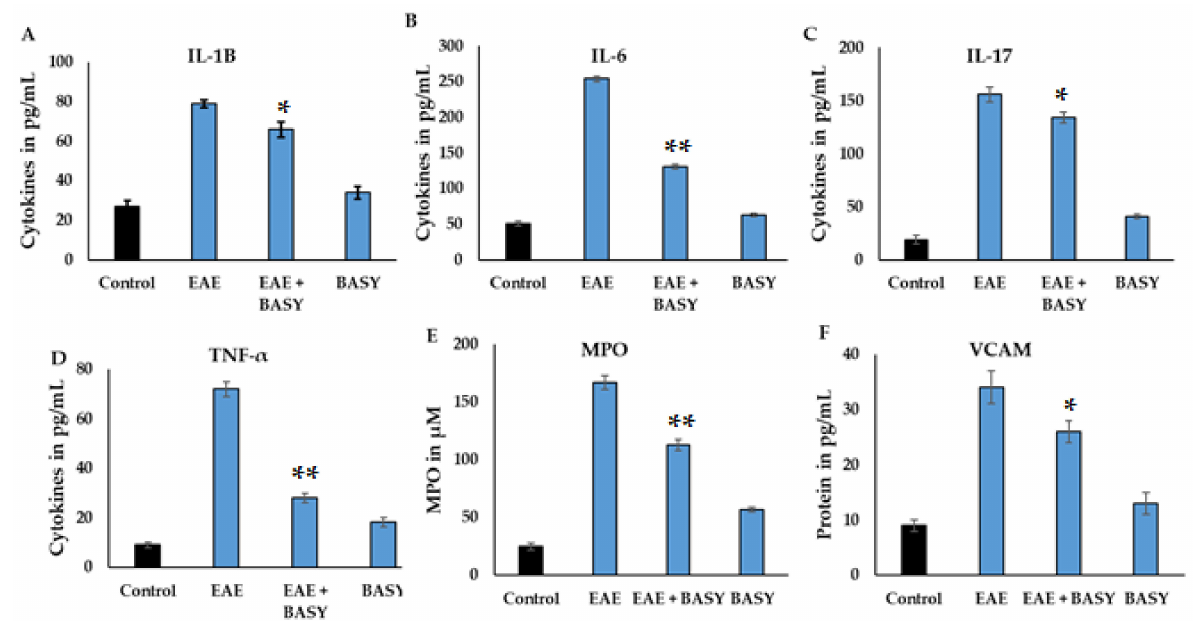
Figure 3. Effect of BASY on inflammatory markers (IL-1B, IL-6, IL-17 and TNF- α ), oxidative damage (MPO) and cell adhesion (VCAM) markers in CNS of MOG-induced EAE mice. These markers were quantified in MOG-induced EAE mice and BASY-treated mice after 24 days of the experiment. The protein markers were extracted from the CNS of MOG-immunized mice. The tissues were homogenized after 21 days of induction using RIPA lysis buffer. The cytokines and chemokines were quantified using Invitrogen and Cayman ELISA kits. ( A ) IL-1B was quantified using an Invitrogen kit. The TMB optical variation was quantified at 450 nm by the microplate reader, and values were expressed in pg/mL. ( B – D ) IL-6, IL-17 and TNF-alpha were quantified using the Cayman kit. ( E , F ) The oxidative stress marker MPO and adhesion molecule VCAM were quantified in the periphery of the spinal cord tissues, respectively. All data were collected from three individual experiments, pooled, and expressed as mean ± SD ( p < 0.05). * p < 0.05 and ** p < 0.01 represents significance compared to the MOG vs. MOG+ BASY group. IL—interleukin; TNF- α —tumor necrosis factor alpha; MPO—myeloperoxidase; VCAM—vascular cell adhesion